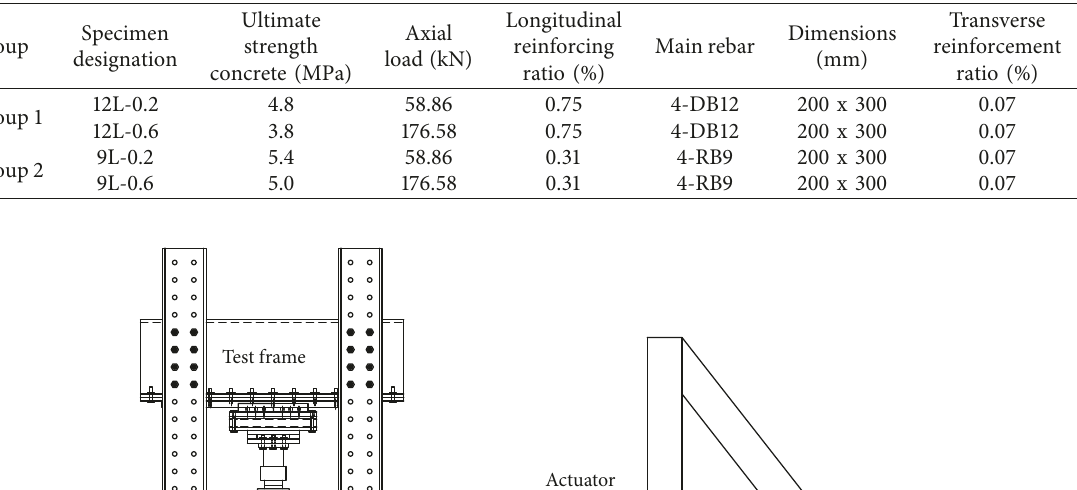
Table 2: Properties of column specimens.